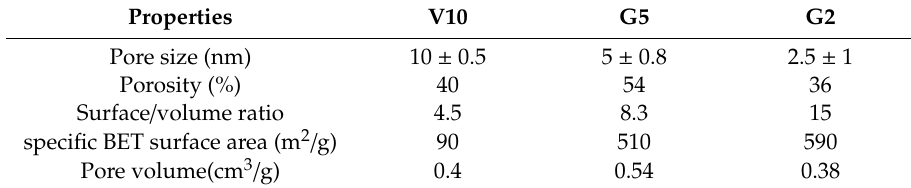
Table 1. Characteristic data of mesoporous silica monoliths of Vycor and